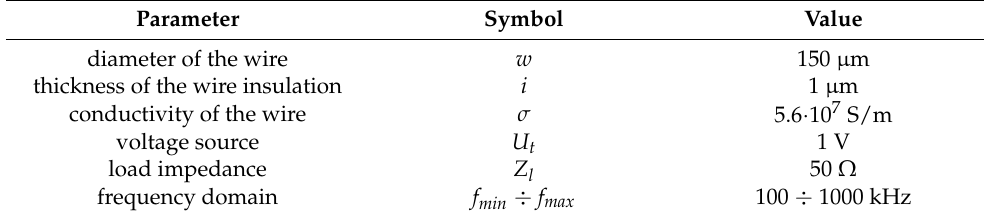
Table 1. Parameters of the wire used to form the coils.